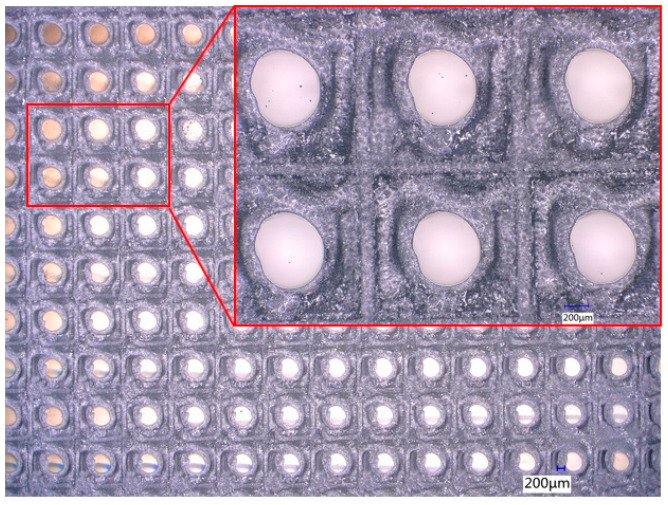
Figure 20. Morphology diagram of square-column round-table secondary microstructures.